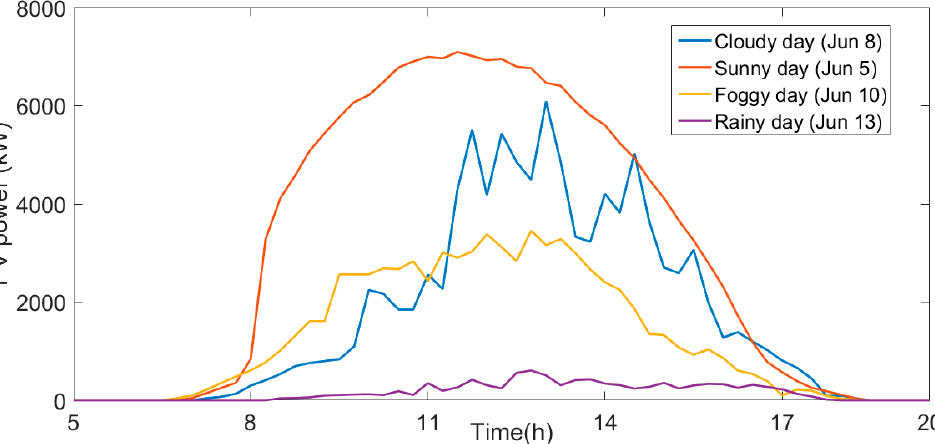
Figure 8. Photovoltaic system power output under different weather conditions.